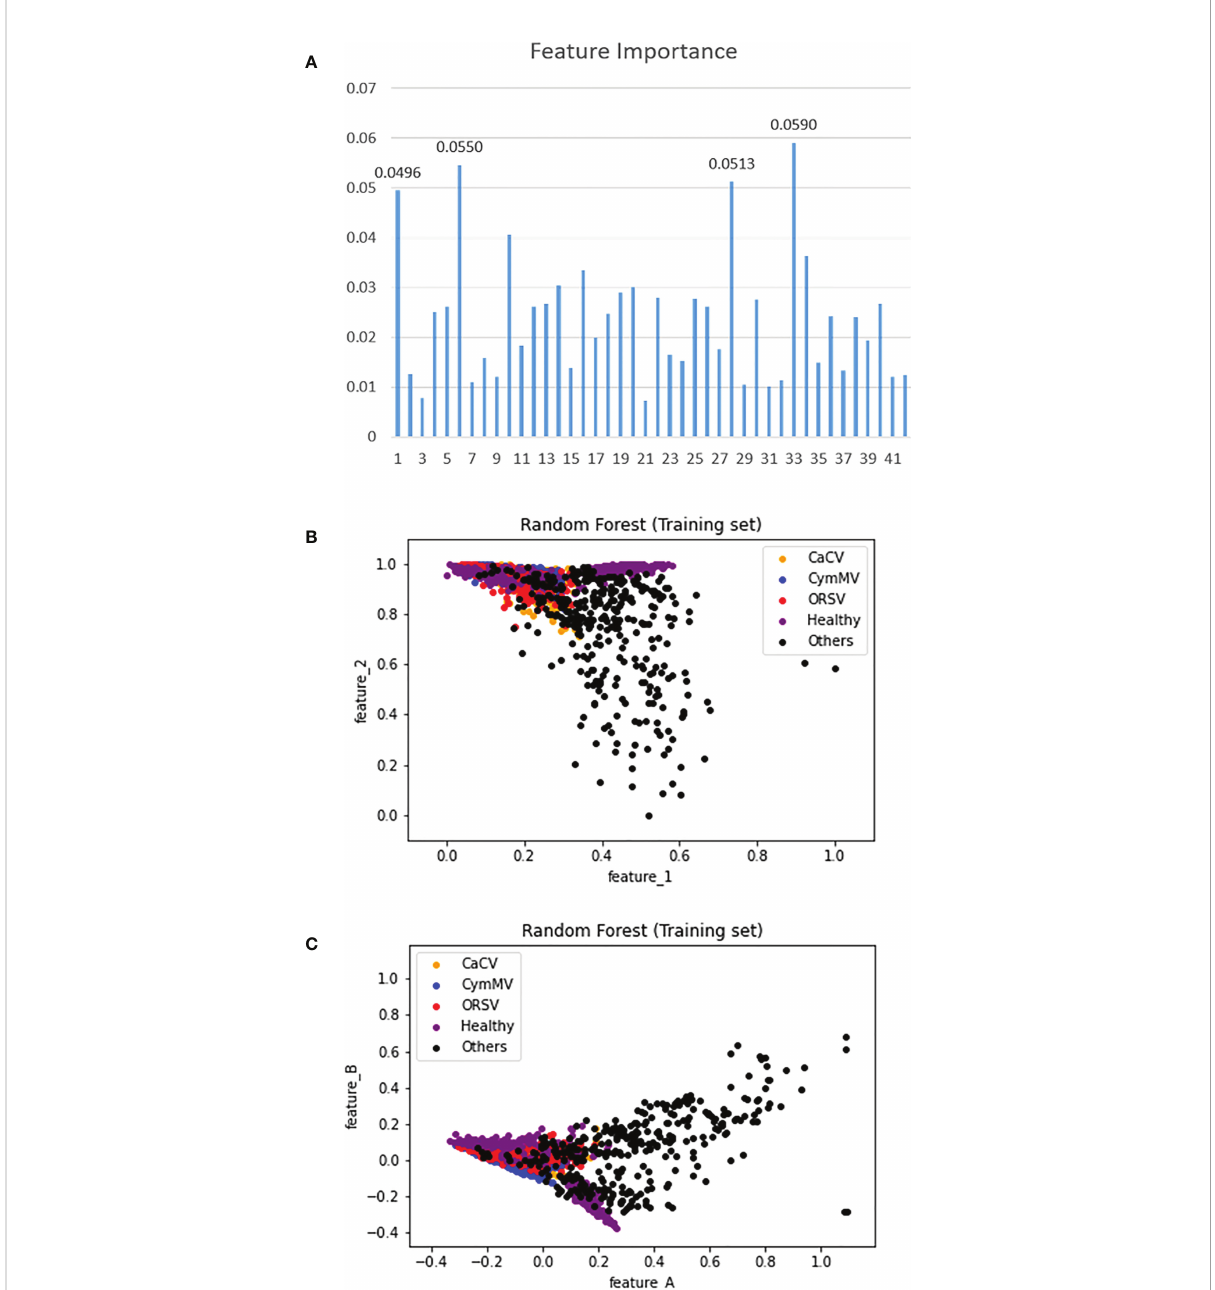
component features shown in Table 4 for preliminary categories identi fi cation of “ others ” and “ non-others ” . Based on the experimental results (Table 5), it was obvious that the identi fi cation performances of two categories (CymMV and ORSV) were the lowest among the fi ve categories.